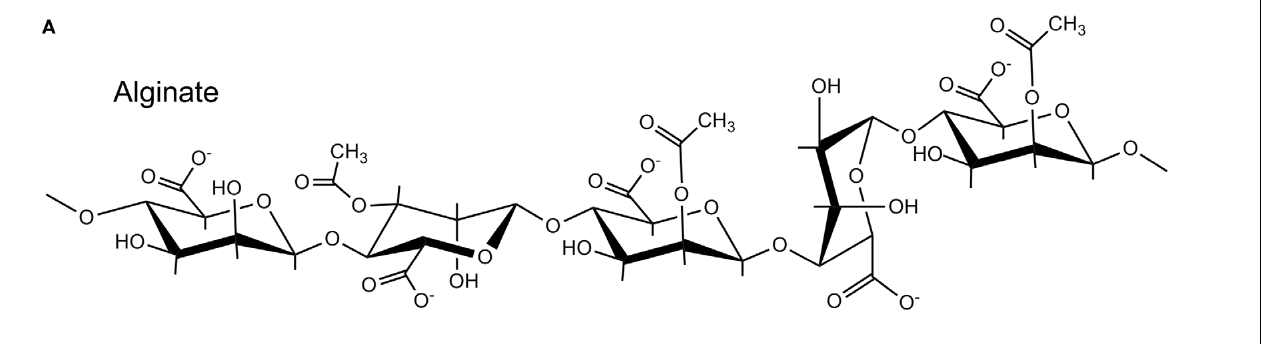
FIGURE 1 | Structures ofAlginate and Psl polysaccharide. (A) P. aeruginosa alginate is composed of D-mannuronic acid residues interspersed with L-guluronic acid residues.The hydroxyl groups of the D-mannuronic acid residues may be O-acetylated at the C2 (cid:2) and/or C3 (cid:2) positions. Since modification of the D-mannuronate residues occurs at the